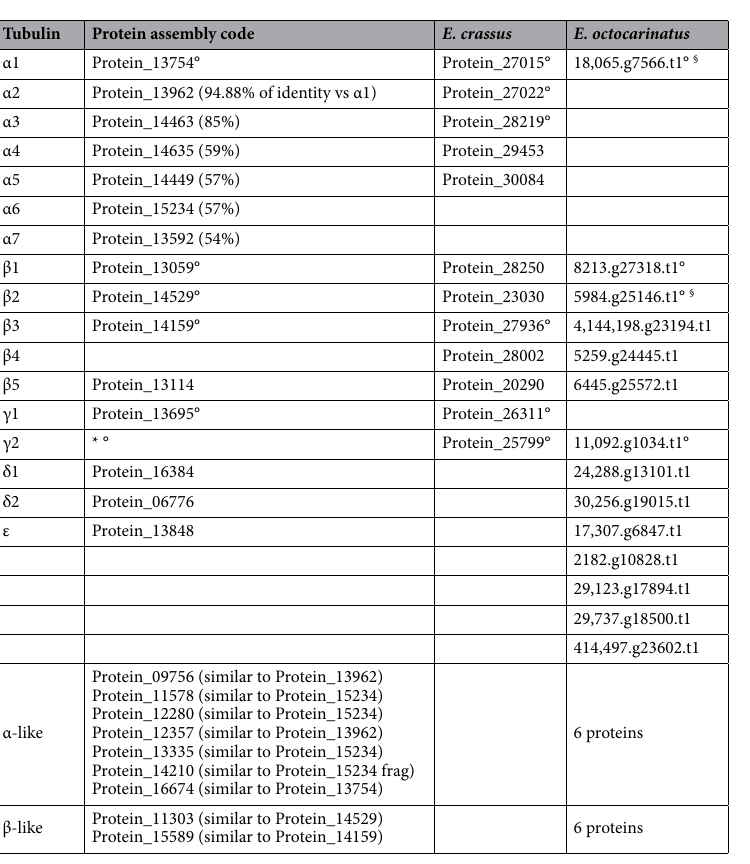
Table 4. Tubulins comparison between E. focardii , E. crassus and E. octocarinatus . *NODE_87922_ length_309_cov_44.0984 (fragment of 309 nt without telomeres only present in the total non-cleaned assembly). Protein sequence already deposited in UniProtKB (the ID numbers of E. crassus proteins are: Q8MM87 for TBα1, Q8MU38 for TBα2, Q8MU39 for TBα3, P20365 for TBβ3, P54403 for TBγ1 and P54404 for TBγ2; the ID numbers of E. octocarinatus proteins are: Q08114 for TBα1, Q08115 for TBβ1, Q0GGY3 for TBβ2 and P90548 for TBγ2). § Contig contains a further sequence portion (in comparison with that deposited in UniProtKB) most likely derived by an assembling or gene prediction